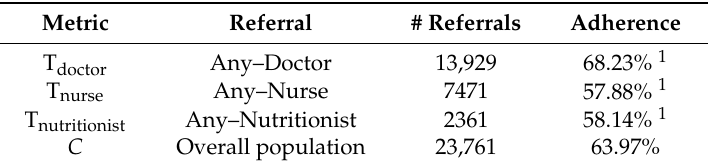
Table 2. Adherence to grouped referrals from any discipline to one discipline in particular.